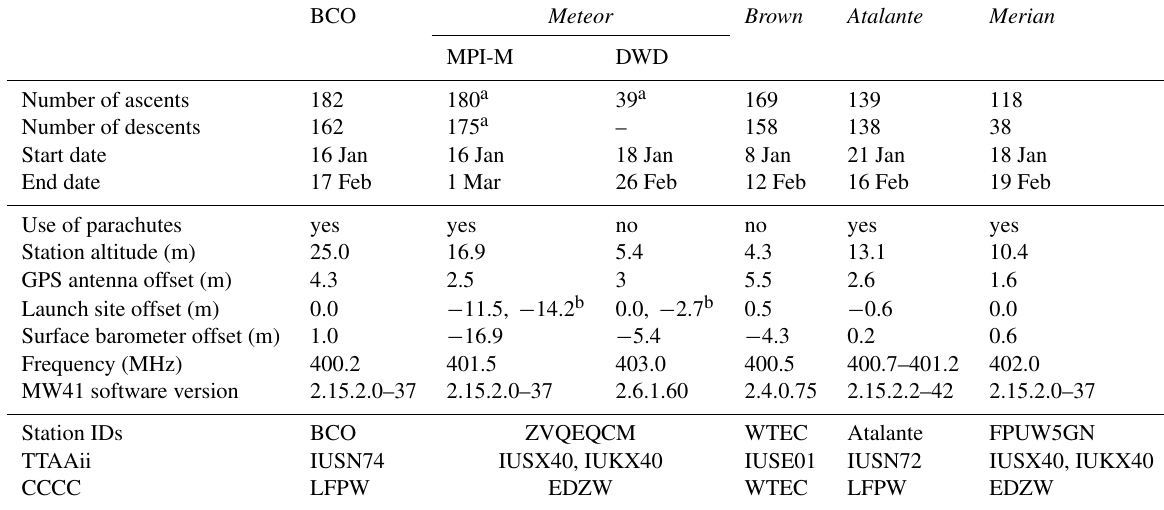
Table 1. For each platform the rows list (1) the numbers of recorded ascending soundings, (2) the numbers of recorded descending soundings, (3) the first date of data coverage, (4) the last date of data coverage, (5) whether or not parachutes were used, (6) the station altitude relative to sea level (for ships: apparent sea level, for BCO: mean sea level), (7) the GPS antenna offset relative to the station, (8) the launch site offset relative to the station, (9) the surface barometer offset relative to the station, (10) the frequency used to transmit the signal from the radiosonde to the antenna, (11) the MW41 software version (12) the WMO station ID, (13,14) the abbreviated heading used for exchange on the Global Telecommunication System, consisting of (13) data designators (TTAAii) and (14) international four-letter location indicators (CCCC) (WMO, 2009).